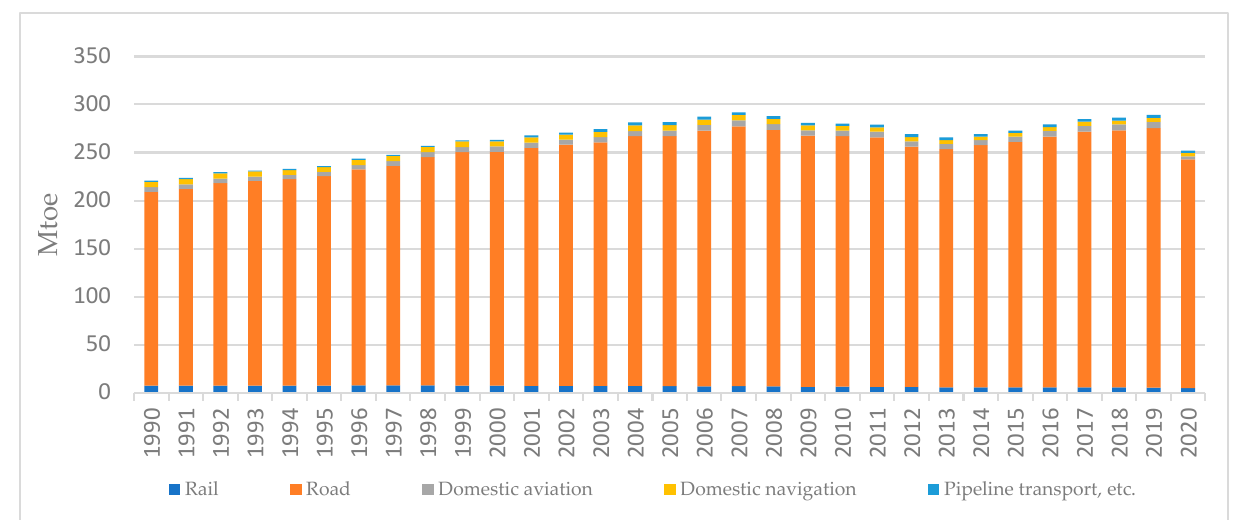
Figure 6. Total energy consumption by transport mode in the EU-27 in the years 1990–2020 (Mtoe). Source: Own elaboration based on Eurostat 2022; European Environment Agency 2022.